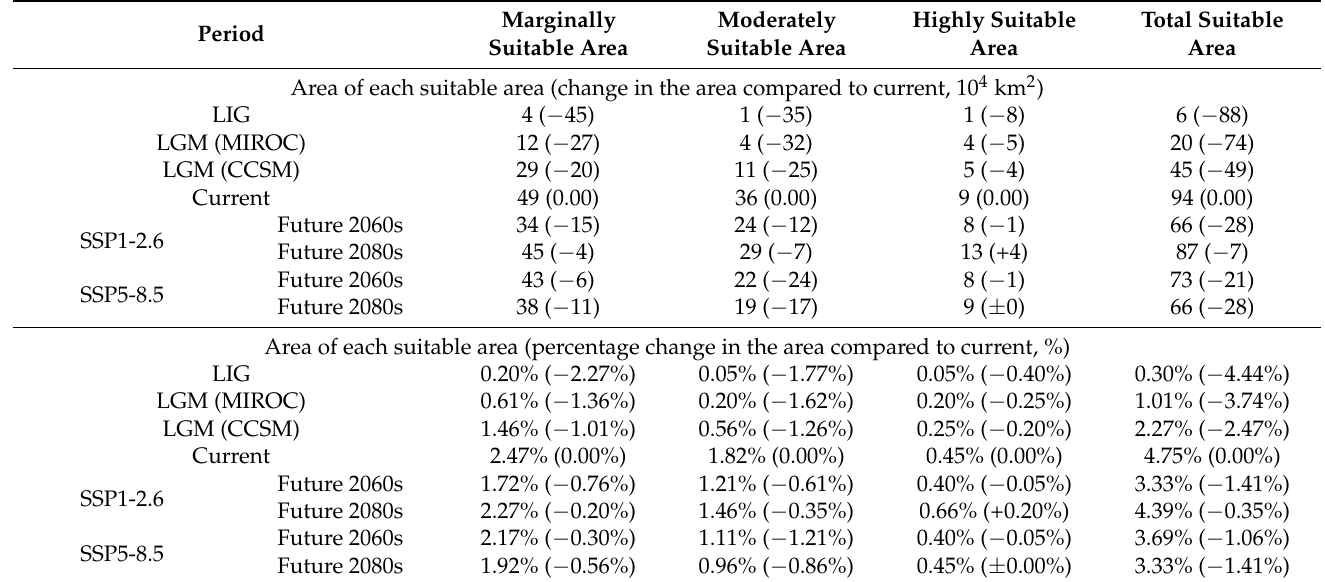
Figure 7. Distribution area changes of A. cordatum in the future under SSP1-2.6 and SSP5-8.5 climatic scenarios. ( a – c ) The distribution areas of A. cordatum in current to 2060s, current to 2080s, and 2060s to 2080s under SSP1-2.6 climatic scenarios. ( d – f ) The distribution areas of A. cordatum in current to 2060s, current to 2080s, and 2060s to 2080s under SSP5-8.5 climatic scenarios. The red area represents the distribution area overlapped or unchanged between the two different periods. The yellow area represents the potential distribution area of current. The blue and green areas represent the potential range of expansion of 2060 and 2080 years, respectively.